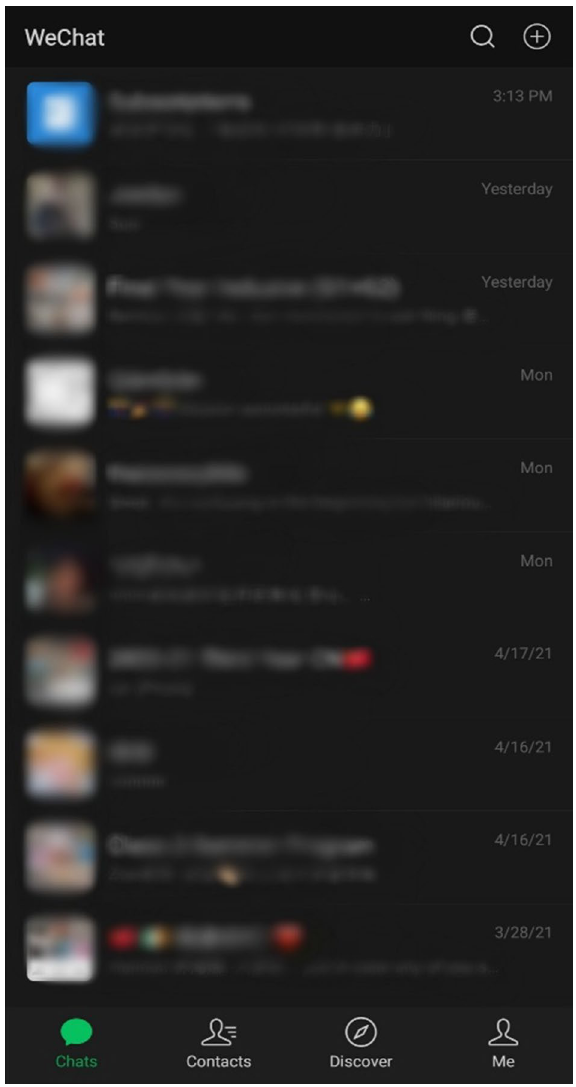
Fig. 6 Home screen of WeChat. Note: The search symbol on the top right-hand side (first on the left) can be used to search for features throughout the